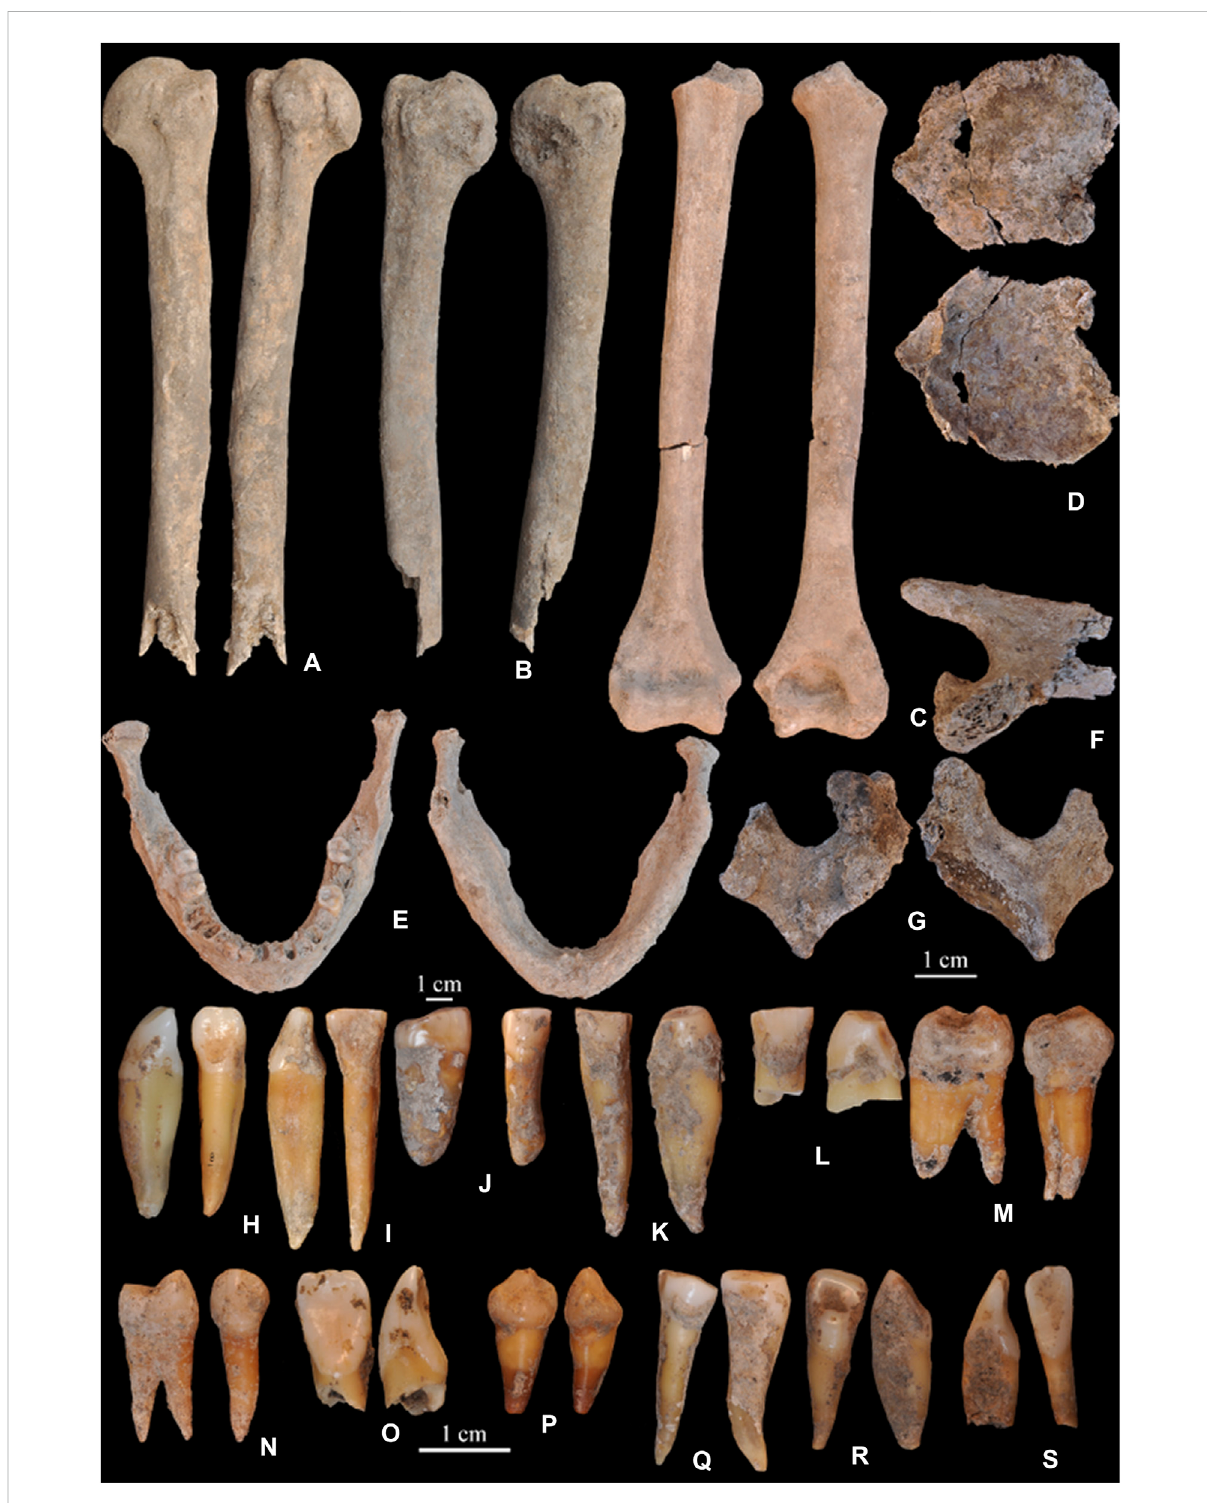
FIGURE 3 HumanremainsfromlayerIV 2 . (A) (Site#3029)humerus. (B) (Site#2996)humerus. (C) (Site#3121)humerus. (D) (Site#3066)frontalbone. (E) (Site#3075)mandible. (F) (Site#2517)scapula. (G) (Site#2777)vertebra. (H) (Site#2303)lowercanine. (I) (Site#2793)lowerincisor. (J) (Site#2595) upper premolar. (K) (Site # 3260) canine. (L) (Site # 3155) canine. (M) (Site # 2618) upper molar. (N) (Site # 2583) upper premolar. (O) (Site # 3334) upper incisor. (P) (Site # 2406) upper canine. (Q) (Site # 3439) premolar. (R) (Site # 3343) incisor. (S) (Site # 3158) upper